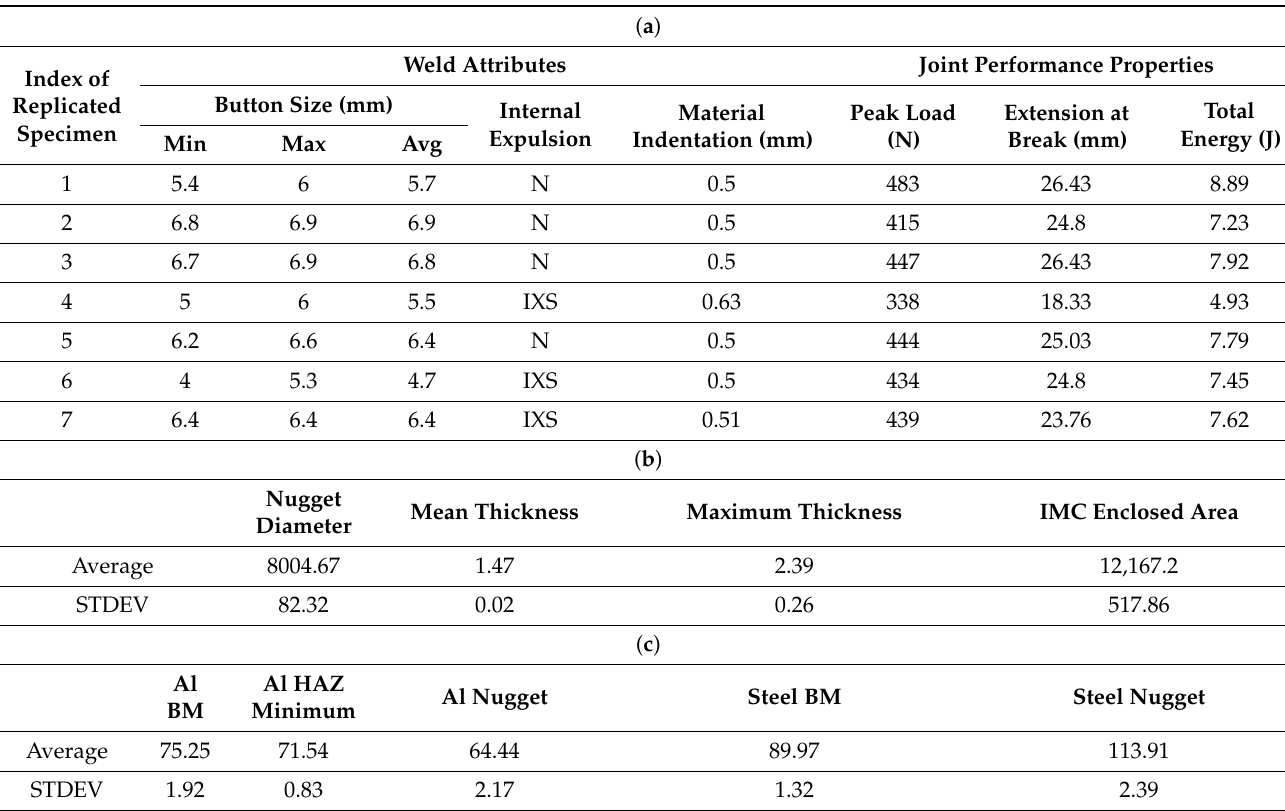
Table 1. ( a ) Experimental measurement of weld attributes and joint performance properties for a variables for IMC thickness variation (unit: µ m), and ( c ) selected feature variables of zone-based hardness (unit: